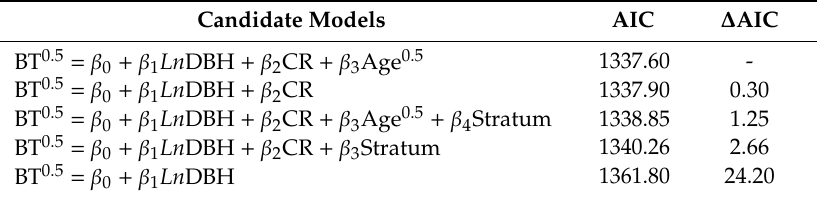
Table 12. Comparing candidate multiaged redwood bark thickness (BT) models. Generalized linear models for square root-transformed BT (mm) as a function of the candidate predictor variables: DBH, crown ratio (CR), breast-height age (years) and the categorical variables for redwood trees in the di ff erent canopy strata and in even-aged stands versus multiaged stands in Jackson Demonstration State